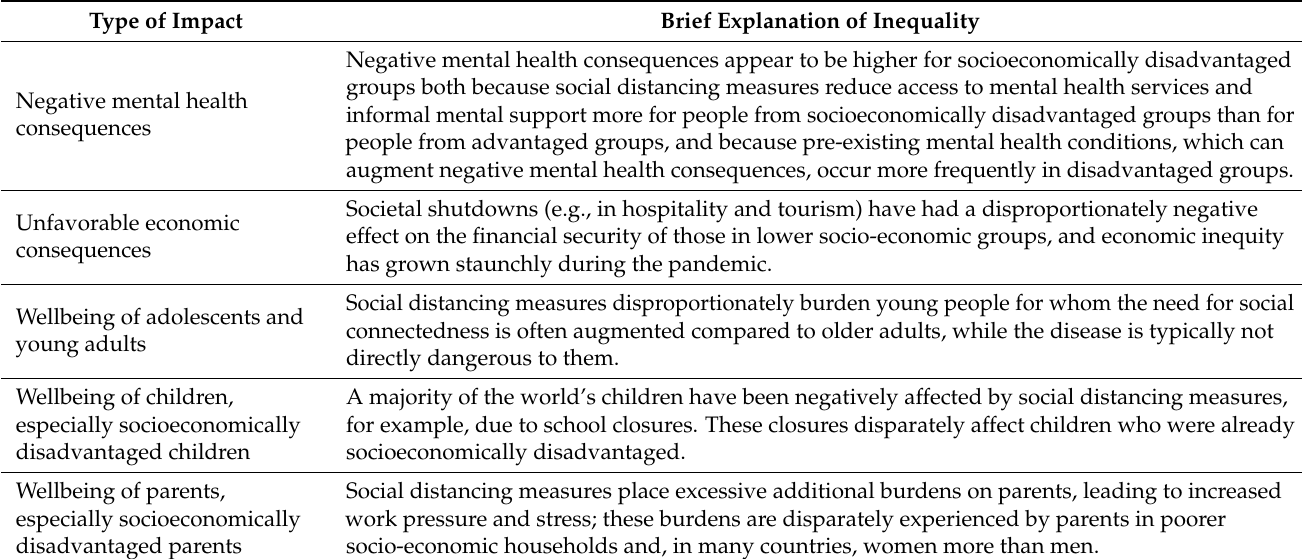
Table 2. Schematic overview of inequalities in the impact of COVID-19 prevention measures. Type of Impact Brief Explanation of